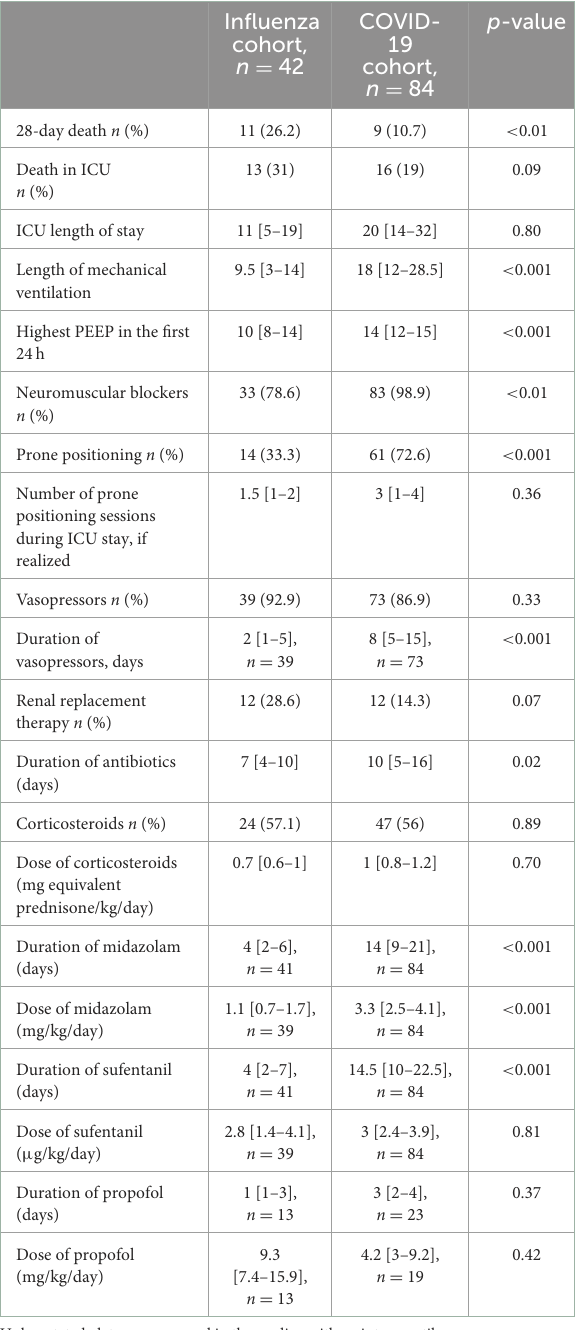
TABLE 2 ICU therapies and outcome.